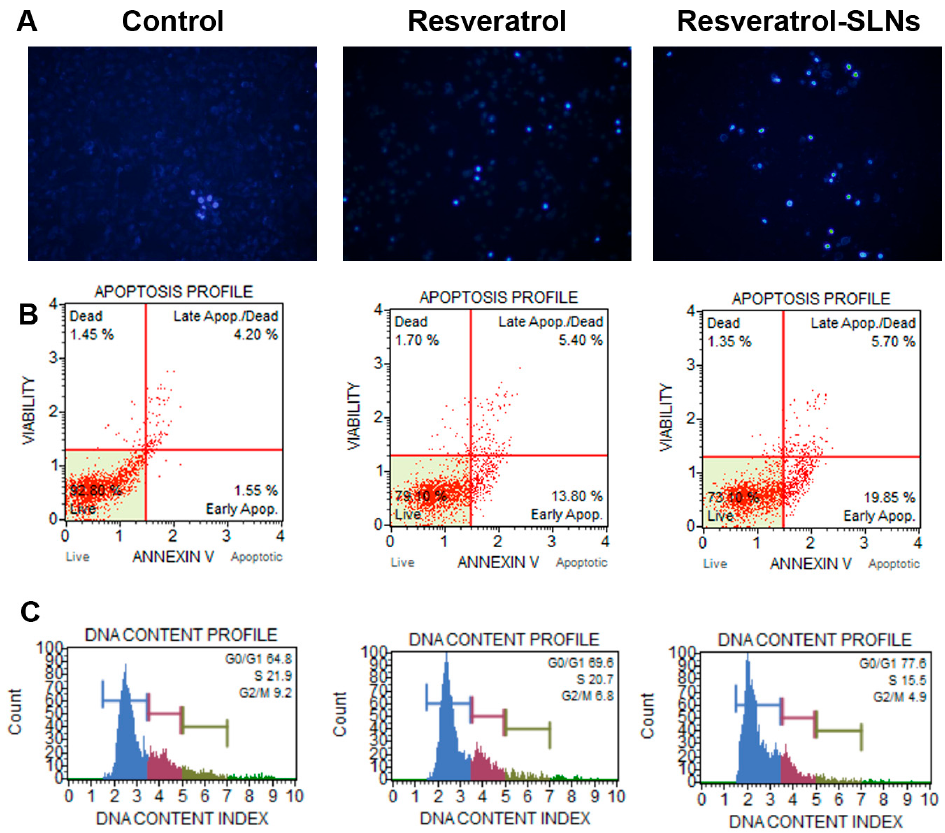
Figure 5. ( A ) MDA-MB-231 cells (×100) stained by Hoechst 33342 after treatments with Resveratrol and Resveratrol-SLNs for 24 h; ( B ) Apoptosis analyzed in MDA-MB-231 cells after 24 h treatment with Resveratrol and Resveratrol-SLNs; ( C ) Cell cycle of MDA-MB-231 cells analyzed 24 h after the treatment of Resveratrol and Resveratrol-SLNs,